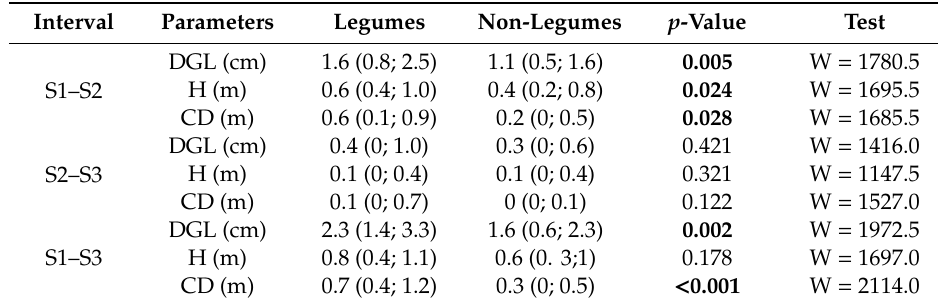
Table 2. Growth in diameter at ground level (DGL), plant height (H), and canopy diameter (CD) of all individuals ( n = 111) by family (legumes and non-legumes), among the three surveys (S1, November 2017; S2, April 2018; and S3, October 2018). Significant di ff erences ( p < 0.05) are in bold. Data are shown as median (with first and third quartiles).